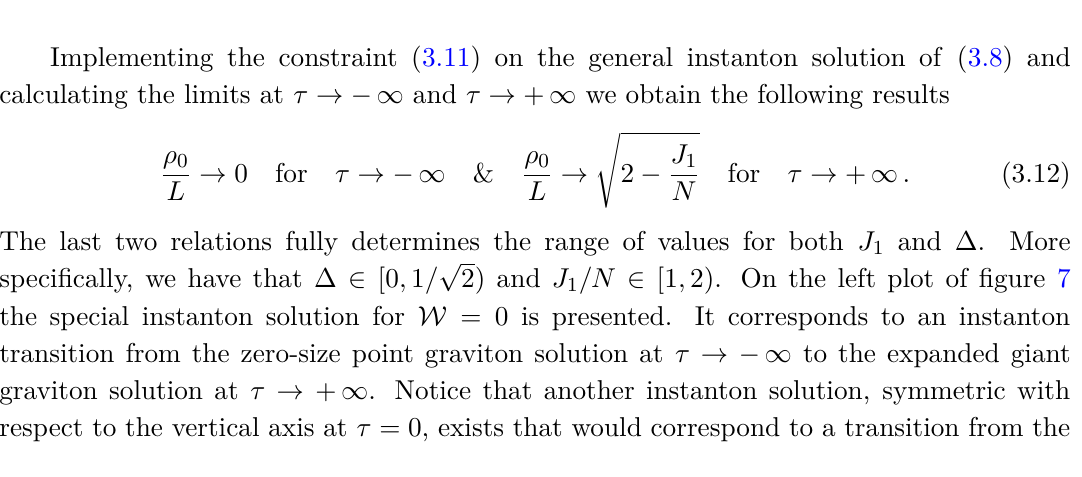
Figure 5 . Total action as a function of J 1 for different values of ∆ . The upper bound for the value of J depends on ∆ , as it is depicted in figure 6. J 1 gridlines emphasize the maximum values for J ∆ is: Blue ⇒ ∆ = 0 . 1 , Red ⇒ ∆ = 0 . 3 & Green ⇒ ∆ = 0 . 5